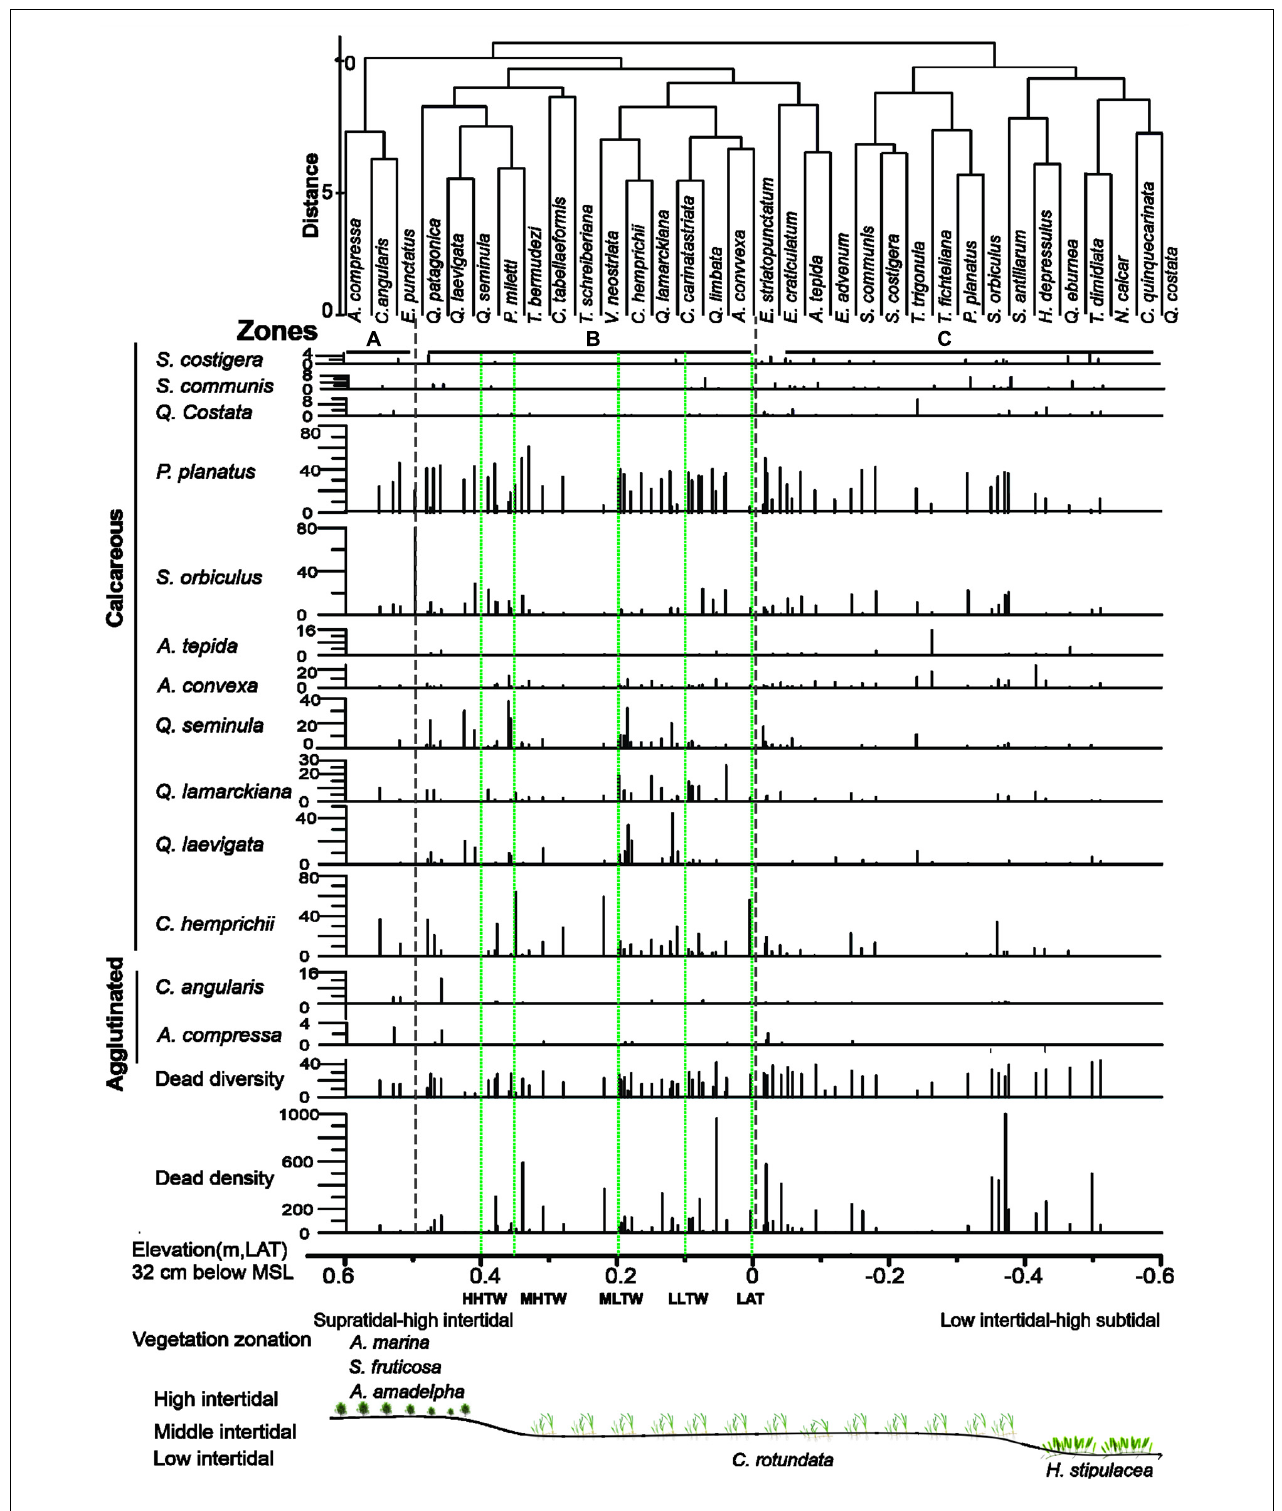
FIGURE 6 | A frequency histogram of the distribution of dead benthic foraminifers across intertidal sabkha vs. the elevation (m, LAT) of the Al-Kharrar Lagoon during March 2014. Cluster analysis of total foraminiferal species based on Log (x + 1) transformed data, and standardized using Bray-Curtis similarity coefficients of group-average. Vegetation zonations based on